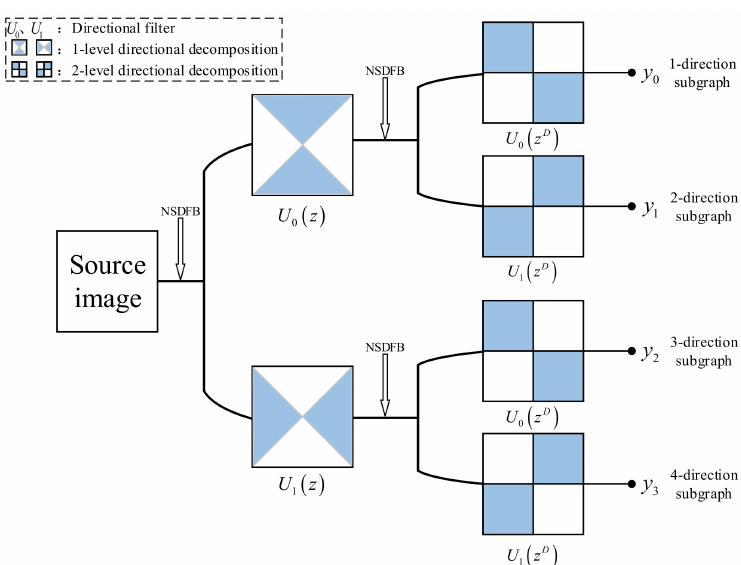
Figure 9. Two-level NSDFB directional filter